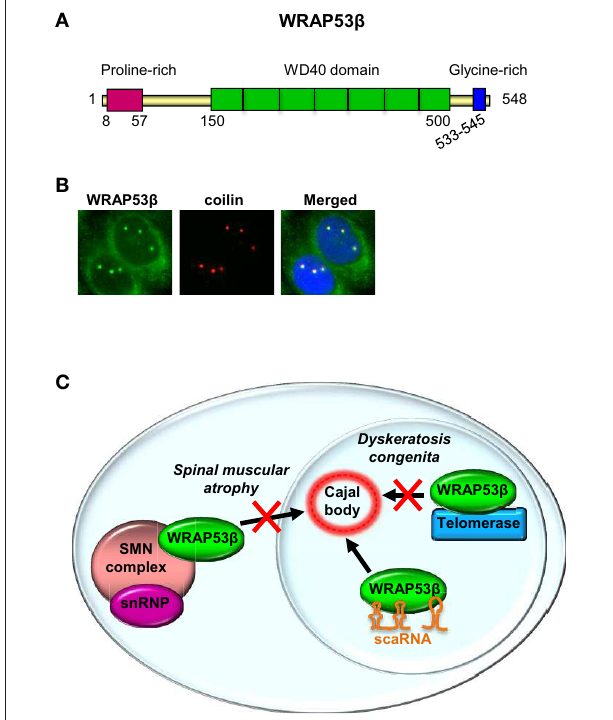
FIGURE 2 | WRAP53 β is a WD40 protein and a hub in Cajal bodies. (A) The structure of WRAP53 β . The numbers indicate amino acid residues. (B) Immunostaining of WRAP53 β and coilin, a marker for Cajal bodies, in U2OS cells ( Mahmoudi et al., 2010). Nuclei were stained with DAPI. (C) Schematic illustration of WRAP53 β -mediated trafficking of the SMN complex, scaRNAs and telomerase to Cajal bodies, and of diseases associated with loss of this